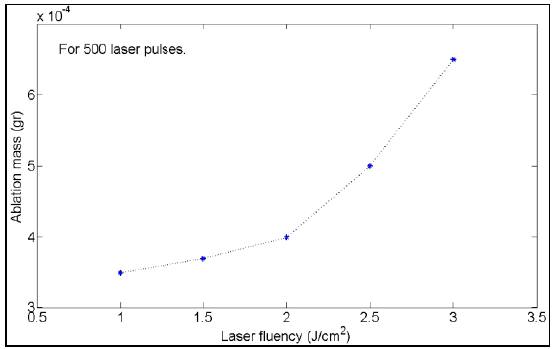
Figure 10. Ablated mass versus laser pulse fluency. Reprinted from [179], an open access article distributed under the Creative Commons Attribution